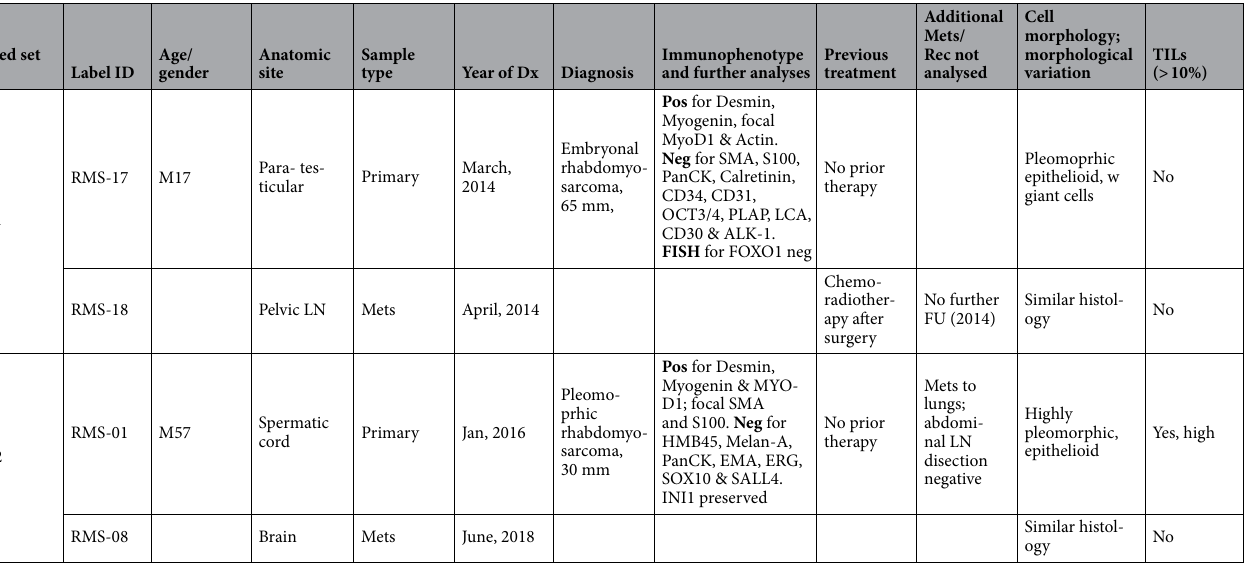
Table 2. Clinical and pathological features of matched myxofibrosarcoma, synovial sarcoma and rhabdomyosarcoma samples. Mets: Metastasis; Gde: Grade (FNCLCC system); Pos: Positive; Neg: Negative; SMA: Smooth Muscle Actin; PR; Progesterone Receptor, ER: Estrogen Receptor; TILs: Tumour-infiltrating lymphocytes; Dx: diagnosis; FU: Follow-up; aCGH: array comparative genomic hybridization; Amp: Amplification; FISH: Fluorescent in-situ hybridization (break-apart